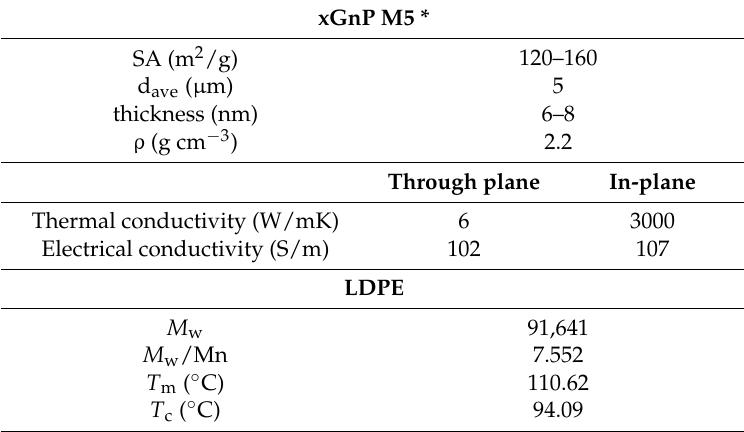
Table 1. Basic characteristics of the LDPE and graphene nanoplatelets.